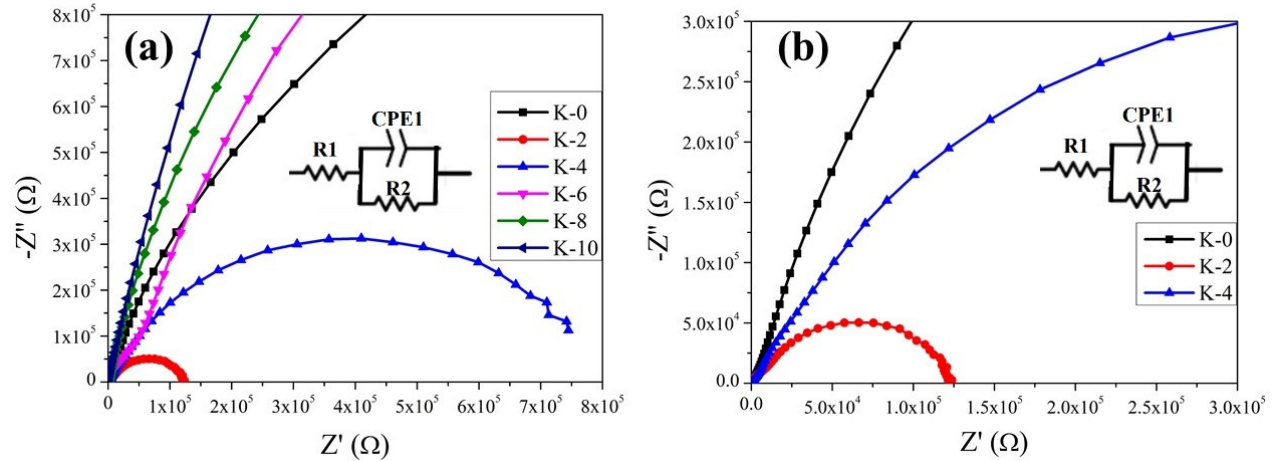
Figure 8. ( a ) Nyquist curves of Cs ₃ Bi ₂ I ₉ devices K-0, K-2, K-4, K-6, K-8, and K-10 (inset: indicates the Nyquist curves’ corresponding circuit). ( b ) Magnification ( a ) and comparison of K-0, K-2, and K-4.